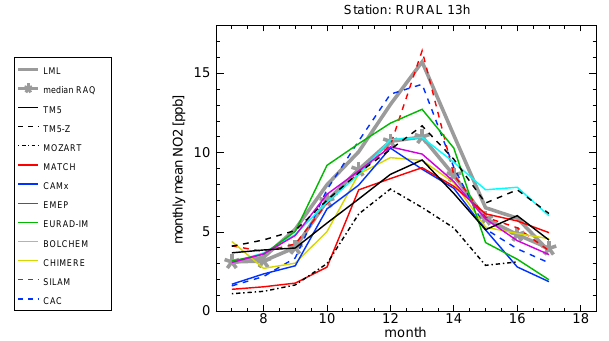
Fig. 10. Comparison of monthly average 13:00 UTC modeled NO 2 concentrations vs. Dutch LML station data corrected for the interference effect. The figures show the average concentrations from 17 rural stations. 9 Diurnal